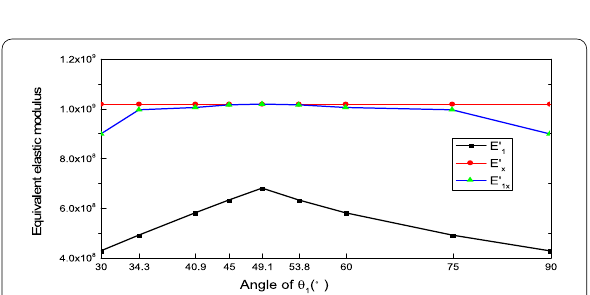
Figure 12 Poisson’s ratio v 12 with varying θ 1 angle in the σ 1 direction